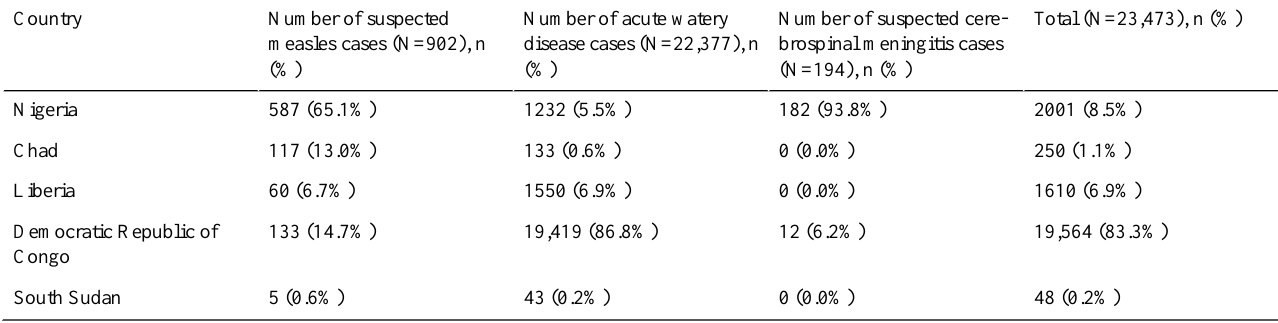
Table 6. Other disease conditions reported by Auto-Visual Acute Flaccid Paralysis Detection and Reporting (AVADAR) informants (August 1, 2017, to July 31,